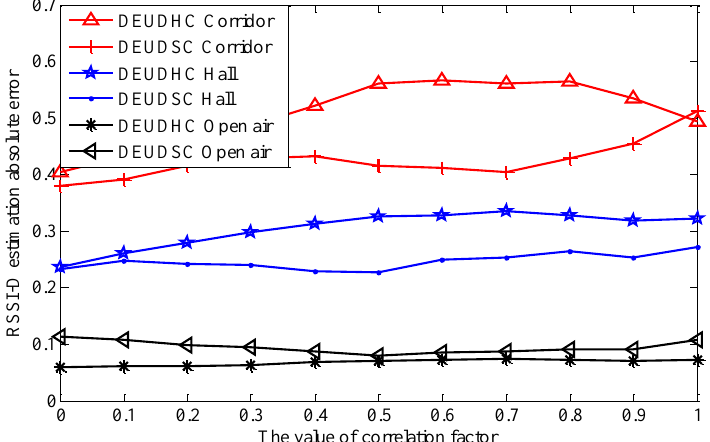
Figure 9. Changes in distance estimation errors with correlation factor in three